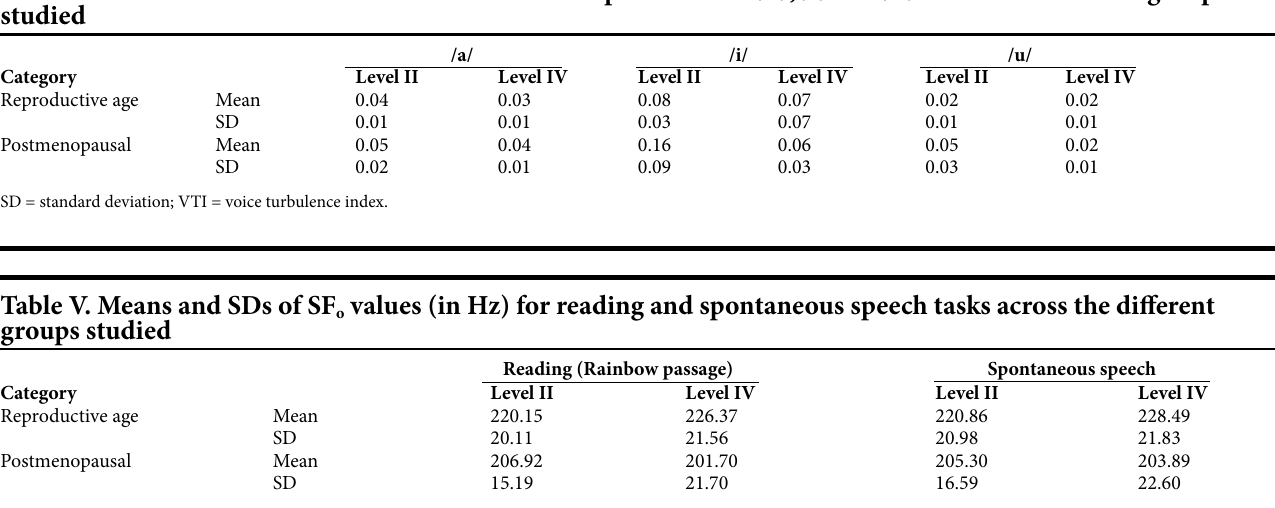
Table IV. Means and SDs of VTI values for sustained phonation of /a/, /i/ and /u/ across the different groups studied